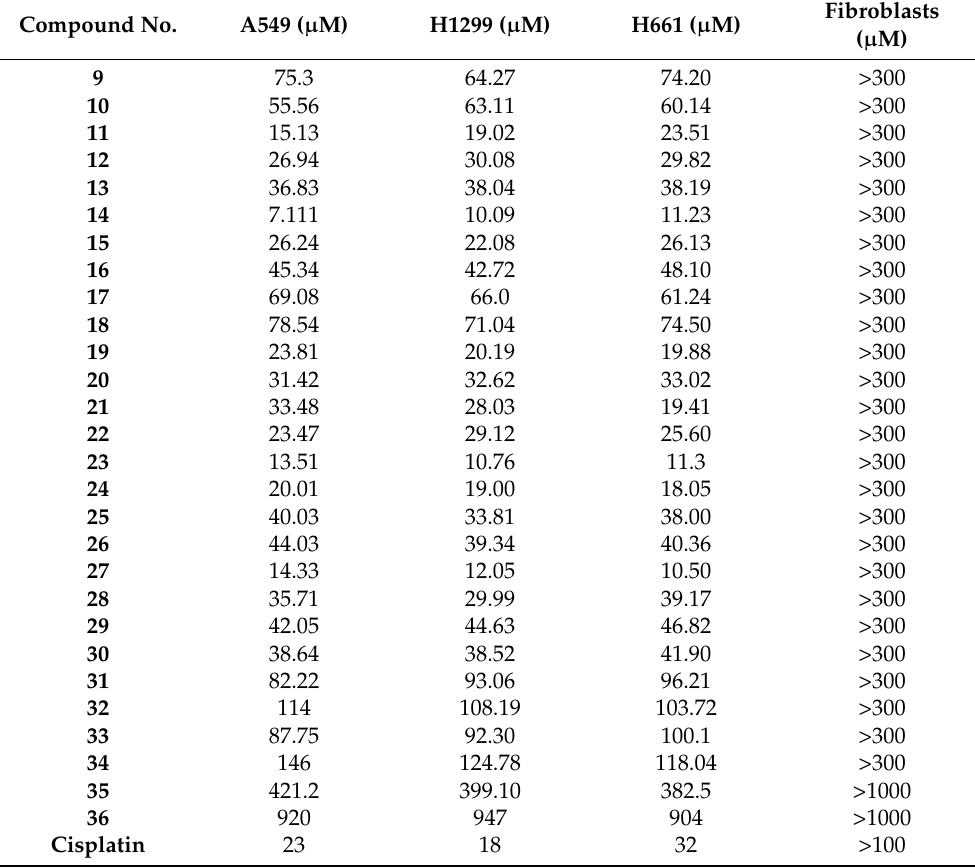
Table 2. IC 50 ( µ M) values of the examined compounds against three different human lung cancer cell lines and the human dermal fibroblasts for 48 h. Data are expressed as mean of three independent experiments (N = 9). SD did not exceed 5%. Compound